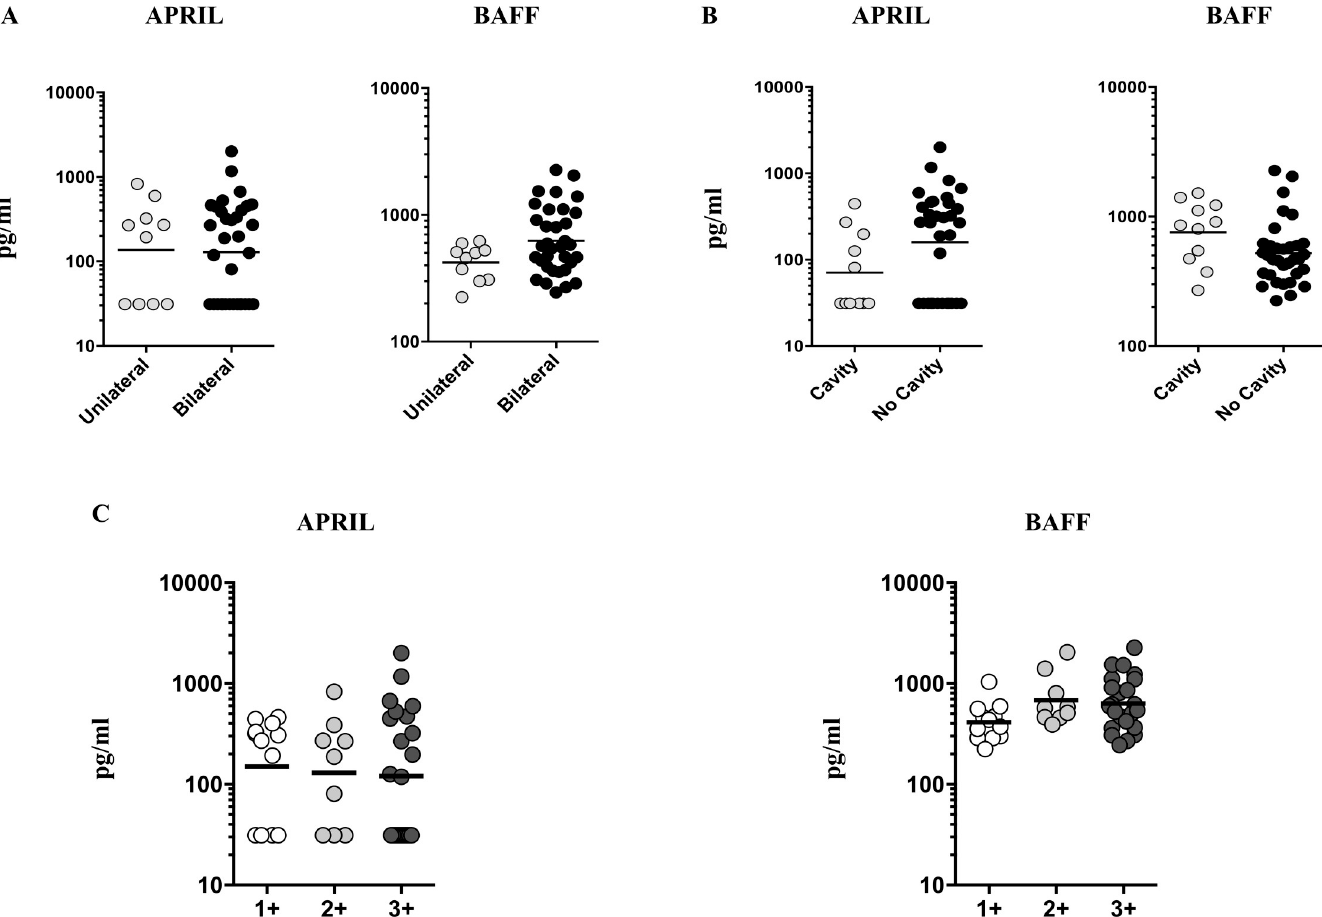
Fig 3. No association of circulating levels of B cell growth factors with extent of disease, disease severity or bacterial burdens among PTB individuals. (A) The plasma levels of B cell growth factors (APRIL and BAFF) in PTB individuals with unilateral versus bilateral, reflecting the extent of disease. (B) The plasma levels of B cell growth factors in PTB individuals with cavity versus non-cavity disease, reflecting the disease severity were shown. The data were shown as bar graphs displaying geometric means and 95% confidence intervals. P values were calculated using the Mann-Whitney test. (C) The relationship between the plasma levels of B cell growth factors and smear grades measured using sputum smears was examined in PTB individuals. The data are denoted as bar graphs showing geometric means and 95% confidence intervals. P values were calculated using linear trend post-test analysis.